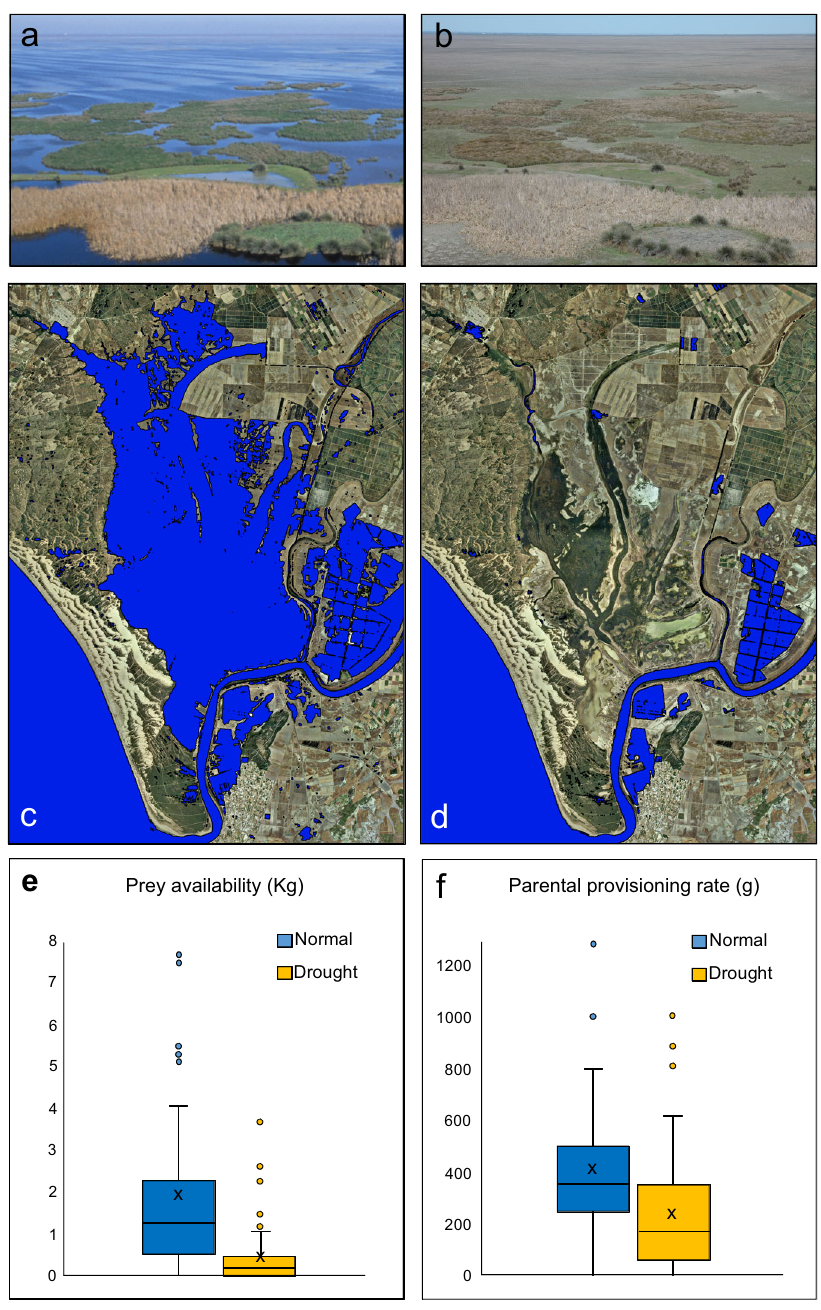
Fig. 2 | Impact of drought on the wetland ecosystem of Doñana National Park (southwest Spain) and on its prey-base available to red kites. Drought condi- tions ( b , d ) convert the large wetland of Doñana ( a , c ) into an arid steppe ( b , d ), imposing a severe reduction in prey availability ( e ), which translated into lower parental provisioning rates to the offspring ( f ). Prey availability is the cumulative mass of prey counted during 120 prey transects ( N =60 transects sampled during drought and 60 transects sampled during normal years; see Methods), while